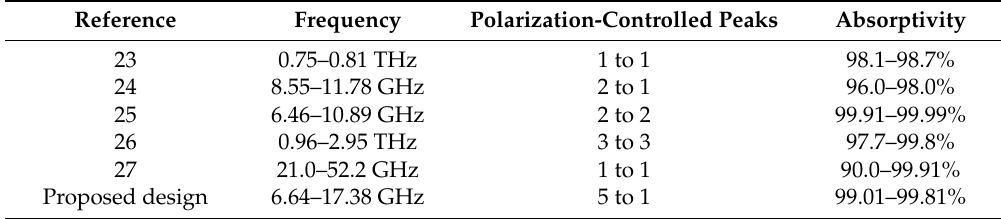
Table 1. Performance comparisons of the proposed absorber with previous